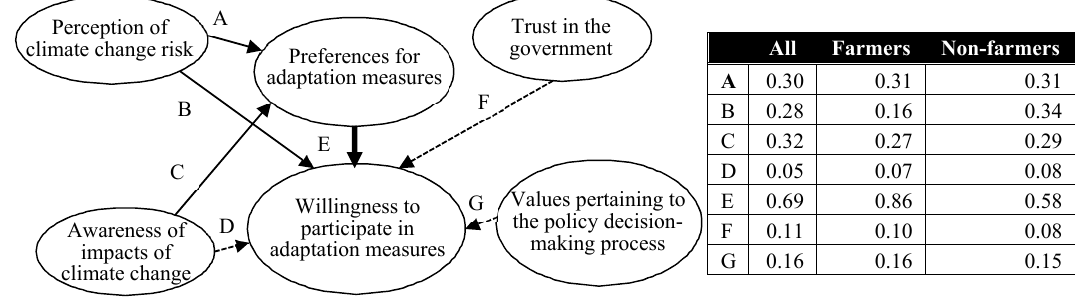
Table 2. Different goodness for fit indices of the results of covariance structure model analysis.